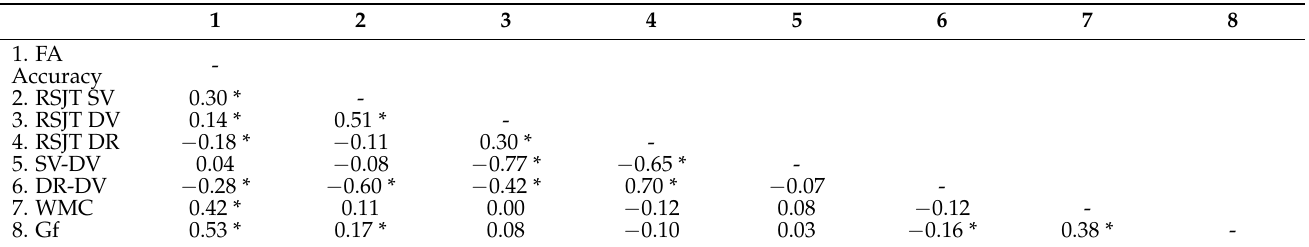
Table 8. Correlations for new RSJT